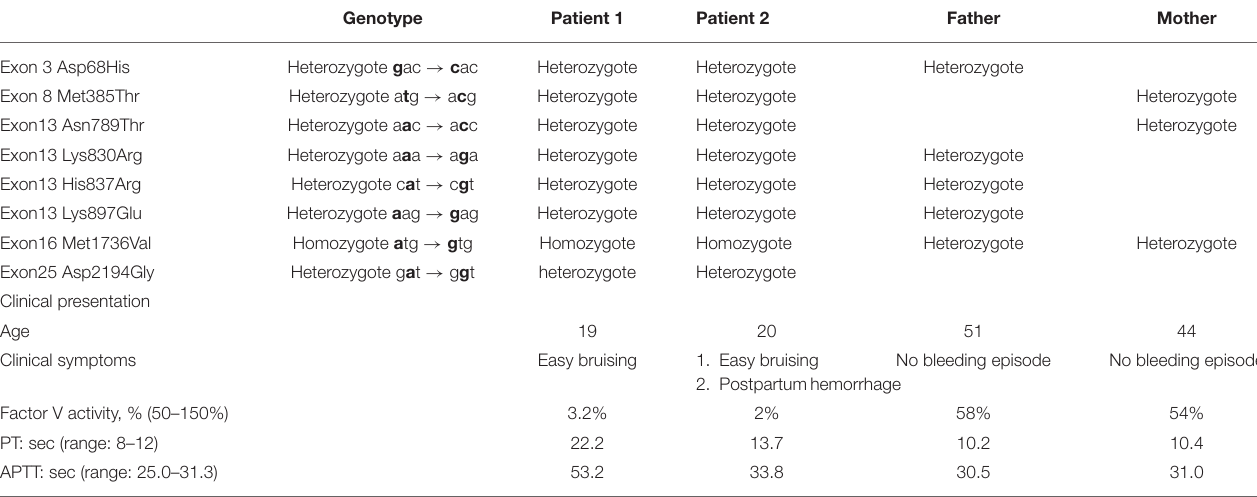
TABLE 1 | The pattern of mutation and clinical symptoms in FV deficiency family.